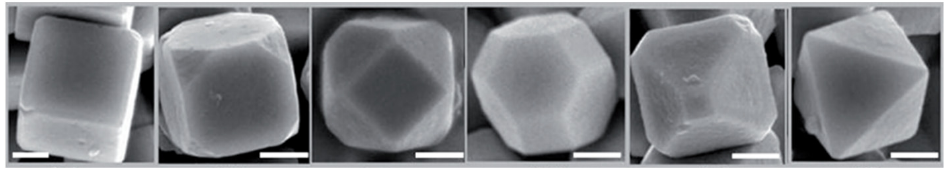
Figure 16. FESEM images of the Cu 2 O polyhedrons with different volume ratios of (100) to (111) [111].